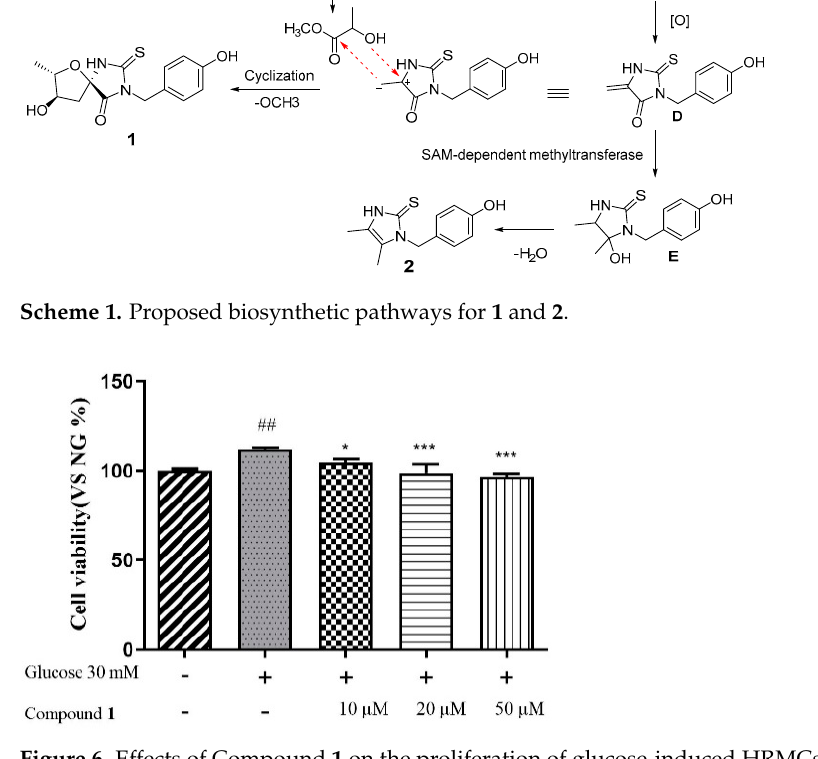
Figure 6. Effects of Compound 1 on the proliferation of glucose-induced HRMCs (* p < 0.05, vs. the 30 mM glucose group; *** p < 0.001, vs. the 30 mM glucose group; ## p < 0.01, vs. the control